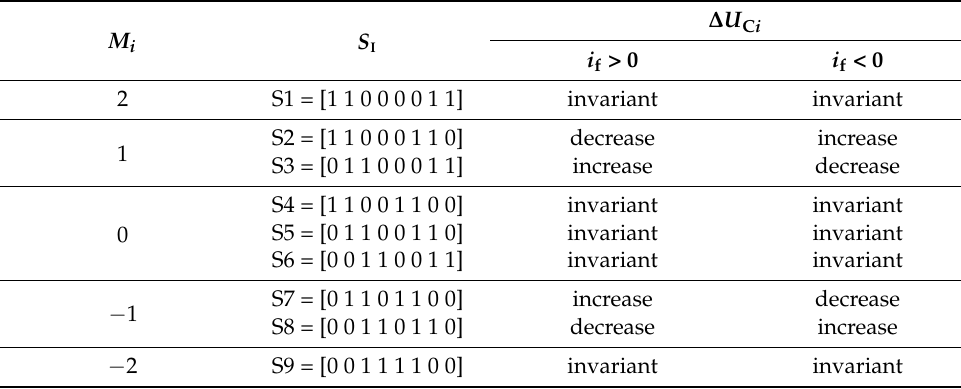
2.2. Discrete Model of the Voltage Mode Digital Power Amplifier Employing